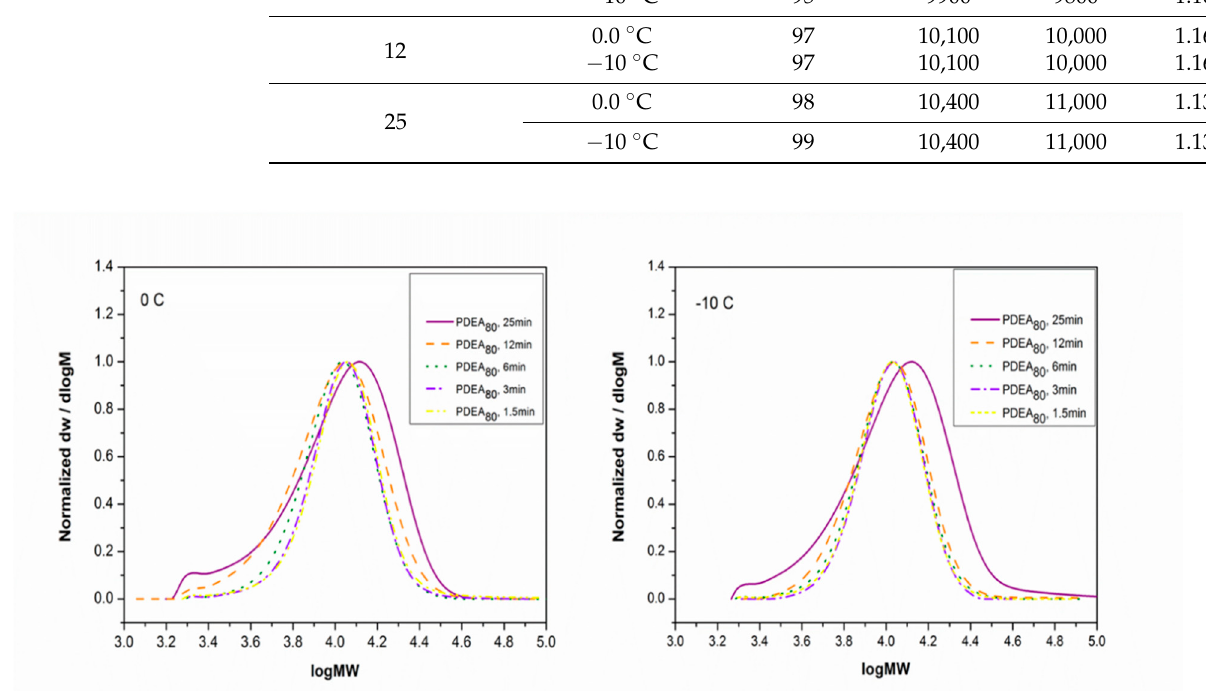
Figure 5. Gel permeation chromatography (GPC) traces showing the molecular weight evolutions for Cu(0)-mediated polymerization of DEA in H 2 O at 0.0 °C and − 10 °C.